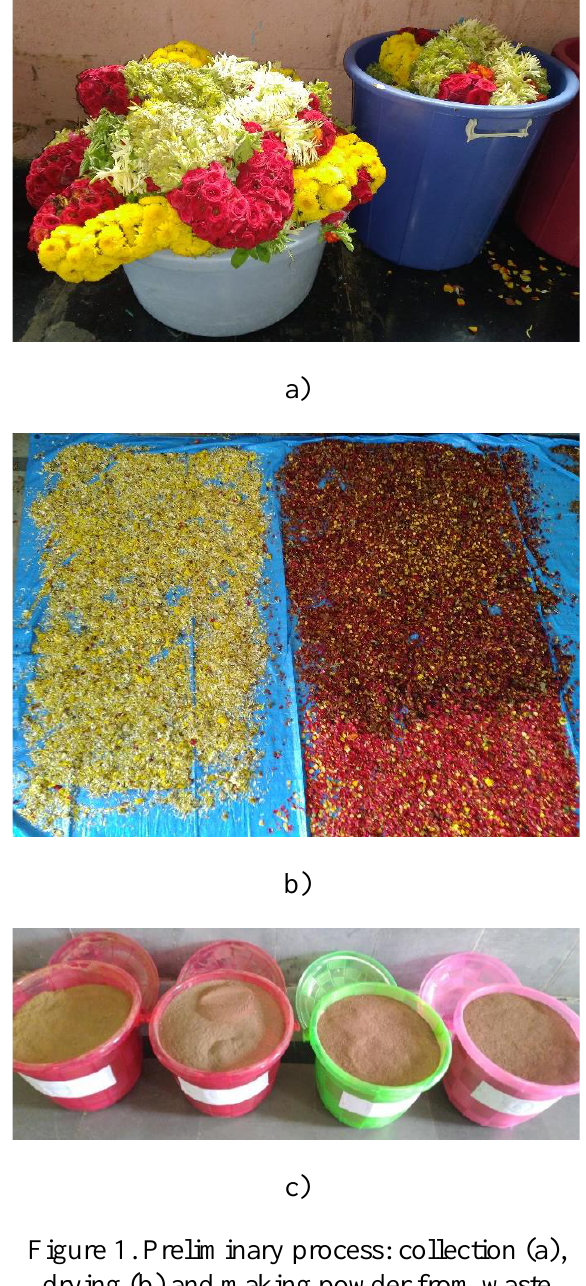
Figure 1. Preliminary process: collection (a), drying (b) and making powder from waste flowers